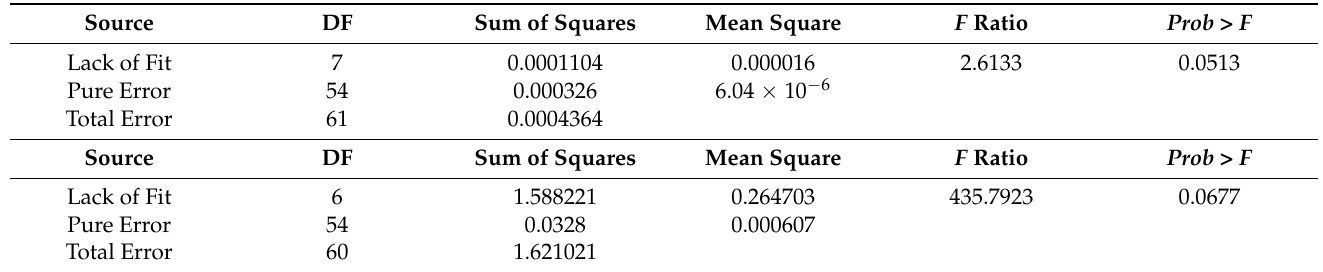
Table 8. Results of the lack of goodness-of-fit test of MSC models for the prediction of the output parameters MRR and Rz in µ -WEDM by